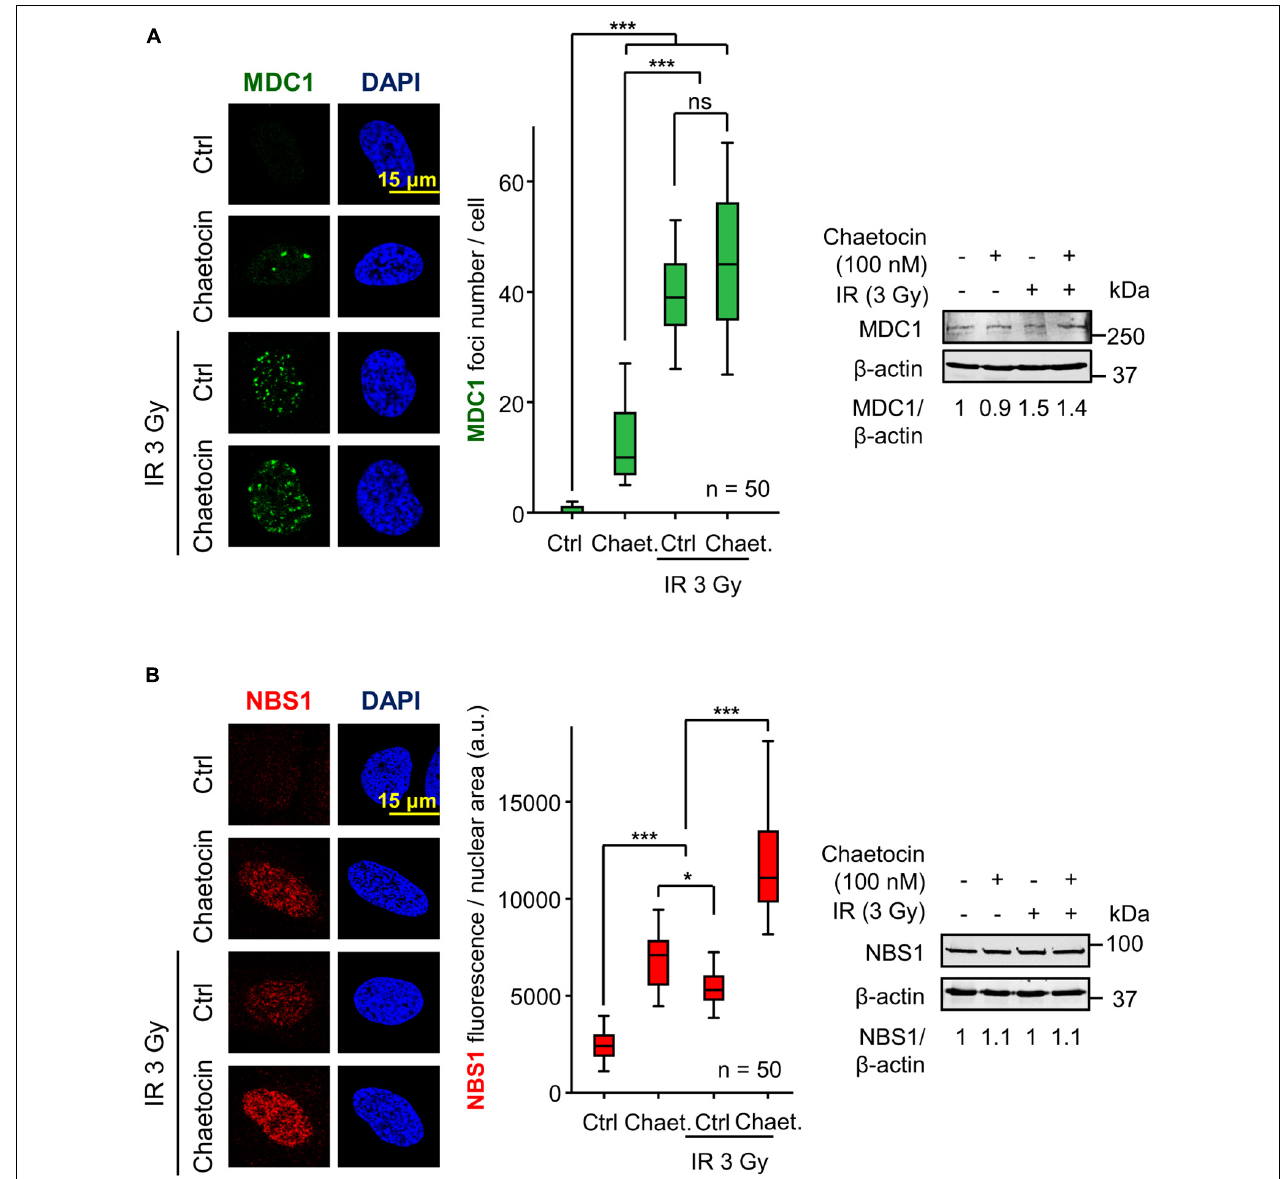
FIGURE 3 | Chaetocin does not interfere with MDC1 foci formation and NBS1 accumulation after inducing DSBs by IR in U2OS cells deprived of serum. (A) Effect of chaetocin on MDC1 foci in response to IR (3 Gy). Quantification of MDC1 foci after treating cells with chaetocin, IR and their combination (center). The immunoblot reflects that no variations in MDC1 protein levels are induced by chaetocin and/or IR (right). ns, not significant. *** p < 0.001. (B) Effect of chaetocin on NBS1 accumulation in response to IR (3 Gy) in U2OS cells. Quantification of NBS1 nuclear fluorescence after treating cells with chaetocin, IR and their combination (center). The immunoblot reflects that no variations in NBS1 protein levels were induced by chaetocin and/or IR (right). ns, not significant, * p < 0.05, *** p < 0.001. Ctrl, control without IR. These images only show the detail in one cell selected for presentation. The field images are shown in Supplementary Figure 5 . Ctrl, control without chaetocin. Chaet, chaetocin (100